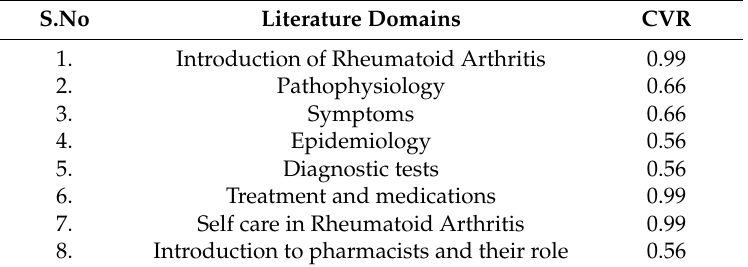
Table 4. Content validity ratio (CVR).